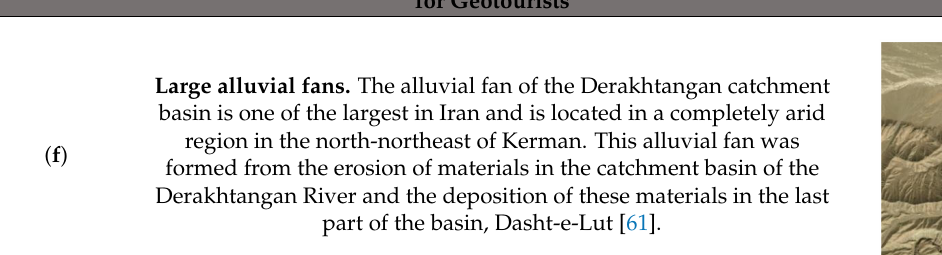
for Geotourists